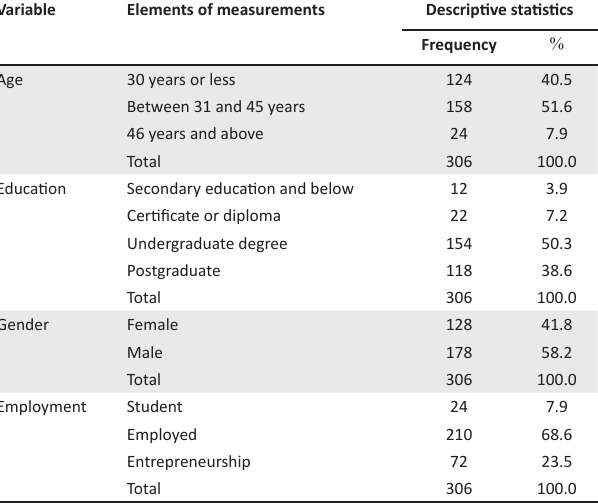
TABLE 2: Demographic characteristics of the participants. Variable